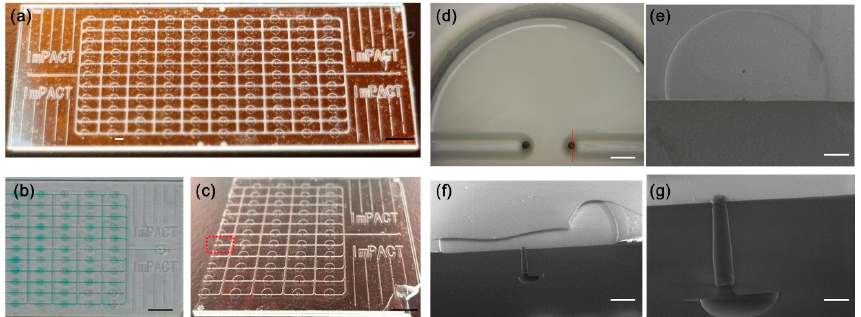
Figure 4. Photographs and valve profile images of prototype. ( a ) Photograph of a large-scale integrated microfluidic device with 110 all-glass monolithic membrane valves; ( b ) Image of valves with colored medium loaded; ( c ) Image of chip after the ultra-thin glass sheets were bonded and cut in half for observation. The black scale bar is 5 mm; ( d ) Image of single valve unit from top side. The white scale bar is 0.2 mm; ( e ) SEM image of valve unit before ultra-thin glass sheet bonding; ( f ) Cross-sectional view showing the details of the valve after glass sheet bonding. The white scale bar is 0.2 mm. The location of the cross-sectional view is shown in ( d ) with the red dotted line; ( g ) Enlarged cross-sectional view of single through-hole structure. The white scale bar is 0.05 mm.